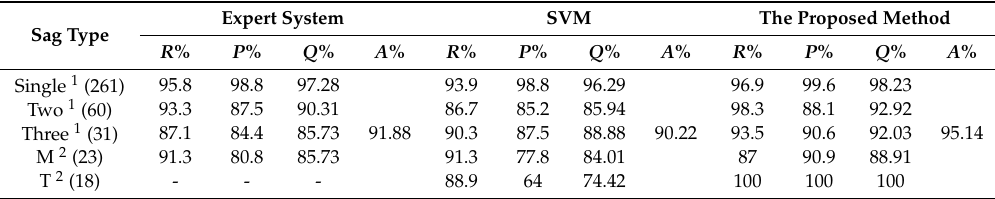
Table 5. Performance of different methods for sag